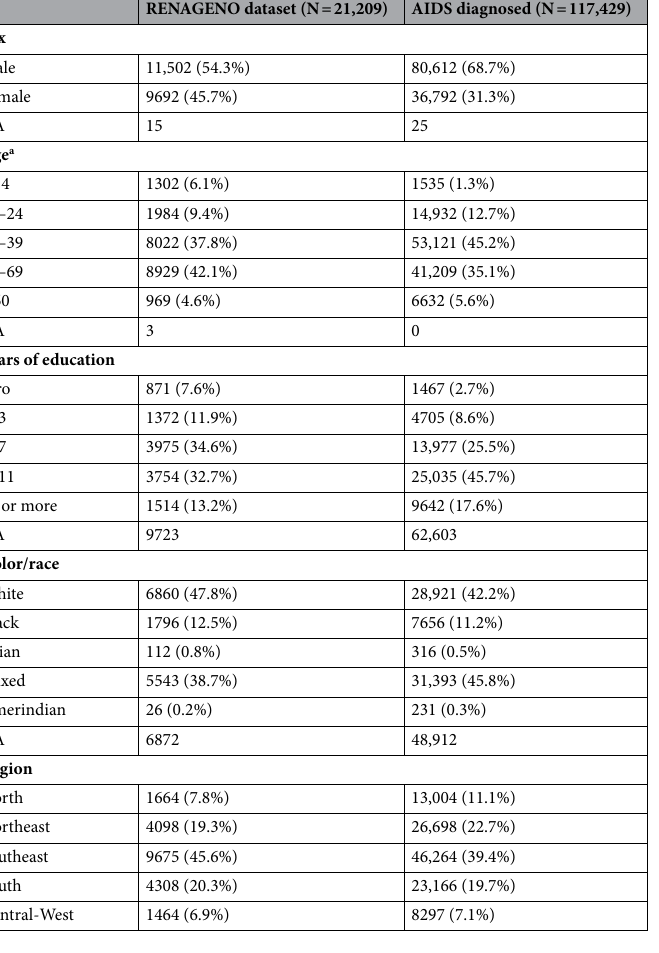
Table 1. Demographic features of the 2015–2017 sampled population in the RENAGENO dataset as compared to the reported AIDS diagnosed individuals in the same period. NA data not available. a When sampled for genotyping or when diagnosed with